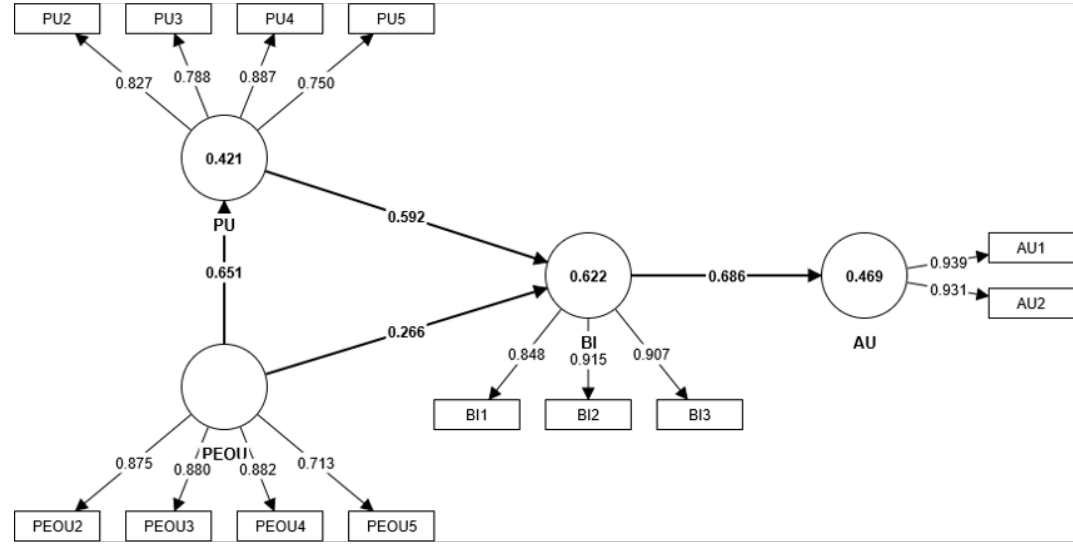
Figure 2. Path analysis